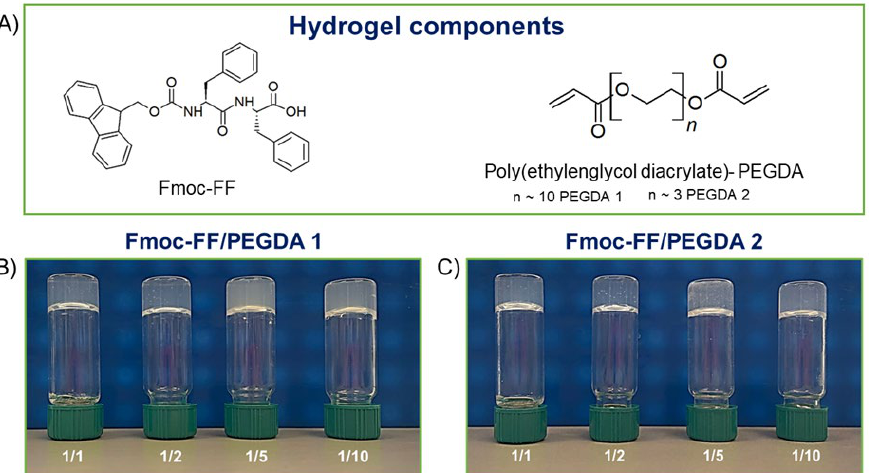
Figure 1. ( A ) Chemical structures of hydrogel components. Inverted tube test for mixed hydrogel formulations (0.5 wt% in Fmoc-FF) with PEGDA1 ( B ) and PEGDA2 ( C formulations (0.5 wt% in Fmoc-FF) with PEGDA1 ( B ) and PEGDA2 ( C ).